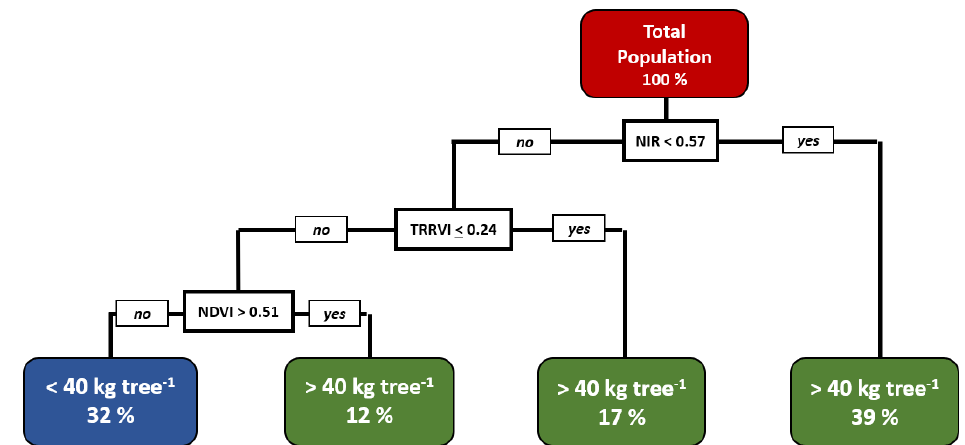
Figure 8. Decision tree analysis for sweet cherry trees classified according to their yield in two situations (higher and lower than 40 kg tree -1 ) considering mean preharvest value of tree’s NIR (near-infrared), TRRVI (transformed red range vegetation index), and NDVI (normalized difference vegetation index) computed in 2018 preharvest.